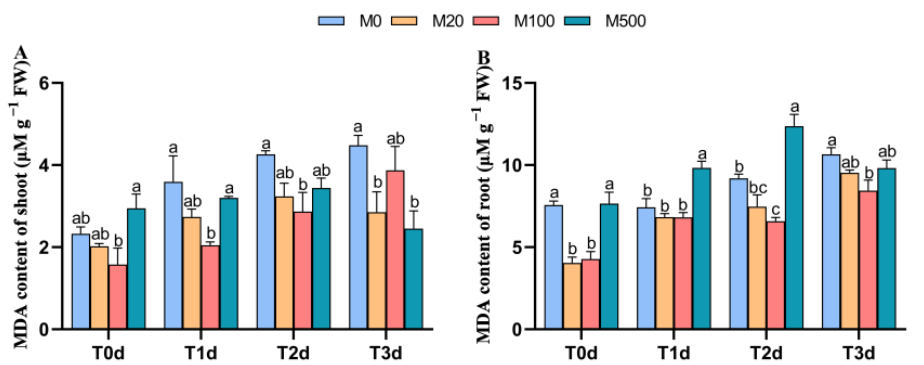
Figure 4. Effects of melatonin and flooding stress on MDA content of shoots ( A ) and MDA content of roots ( B ). Different letters represent statistically significant differences ( p < 0.05).